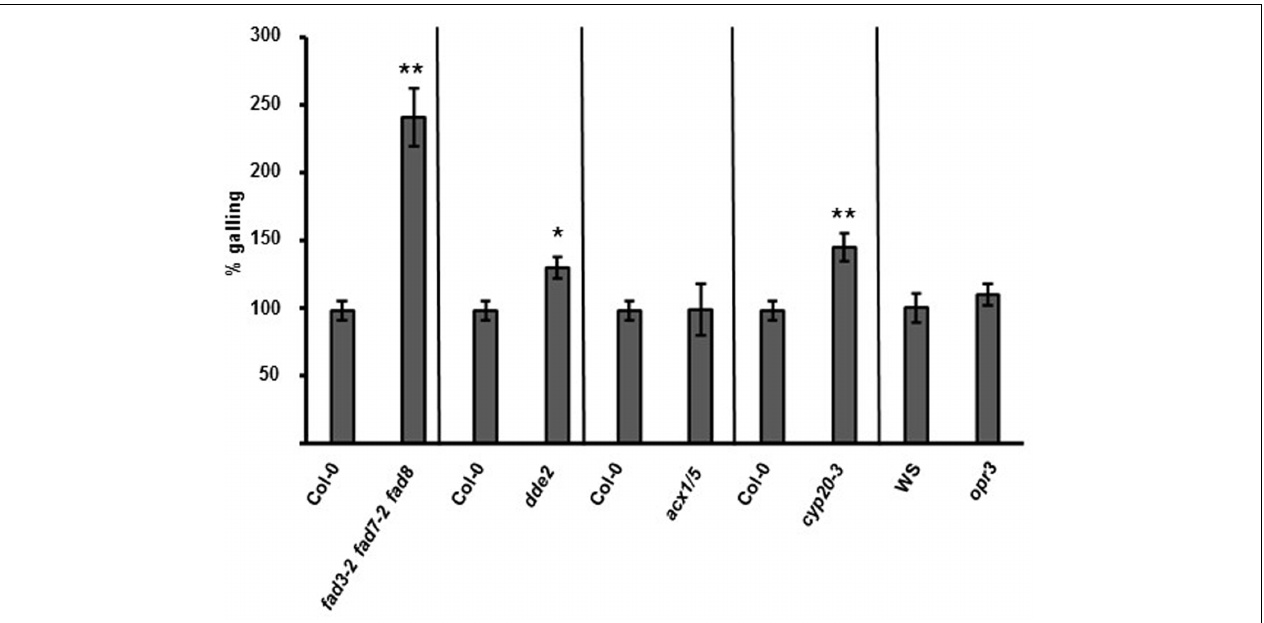
FIGURE 4 | Mutants in the JA biosynthetic pathway show differential susceptibility M. hapla. Fourteen-day-old seedlings on MS media were inoculated with 100 M. hapla J2 per plant and galls were counted at 14 dpi. The average number of galls in Col-0 at 14 dpi was set to 100% and results are means ± SE combined from at least three independent experiments. Galling in each mutant was compared to galling in Col-0 (or the Wassilewskija ecotype (WS) for opr3 ). Asterisk indicates a significant difference between the mutant and control (Welch t -test ∗ p < 0.0005, ∗∗ p < 0.005). ( n = 117, 39, 78, 47, 33, 33, and 29,